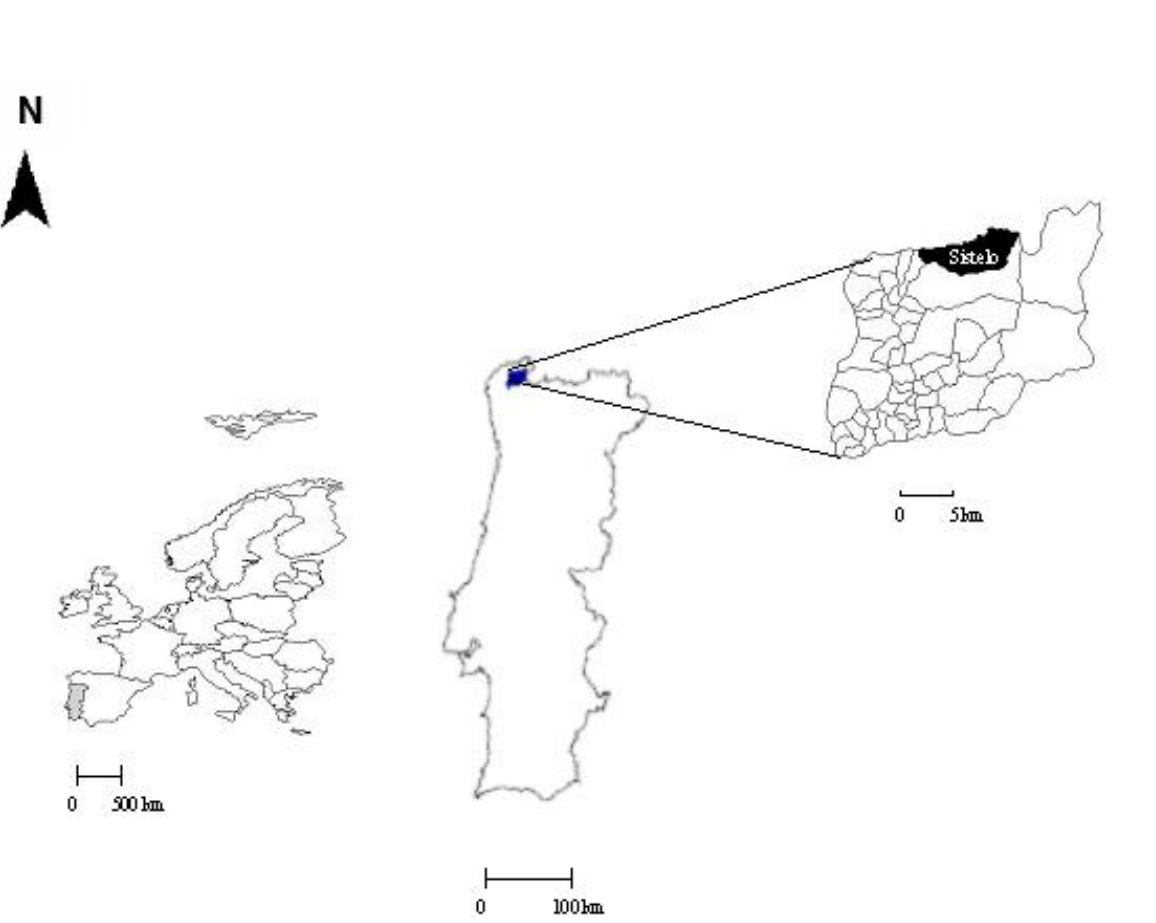
Fig. 2 . The geographic location of Sistelo,